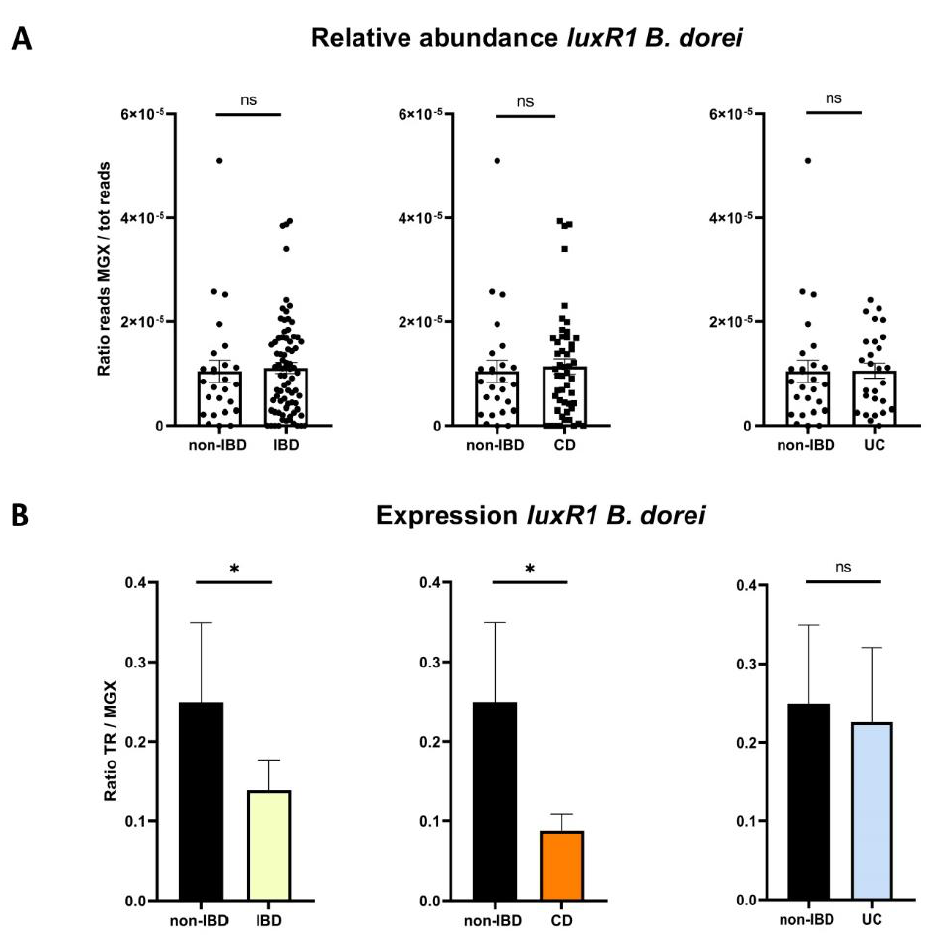
Figure 3. Receptor gene luxR1 Bacteroides dorei (B. dorei) according to disease phenotype. ( A ) Relative abundance of luxR1 B. dorei expressed in the ratio of gene reads recovered by blastn searches over the total number of reads in the sample (Mann–Whitney U test). ( B ) Expression of luxR1 B. dorei expressed by the ratio of gene reads recovered by blastn searches in the transcriptome over the gene reads in the metagenome (Mann–Whitney U test). In all panels, ns: non-significant, * p < 0.05, CD: Crohn’s disease, UC: ulcerative colitis, non-IBD: controls, MGX: metagenome, TR: transcriptome.